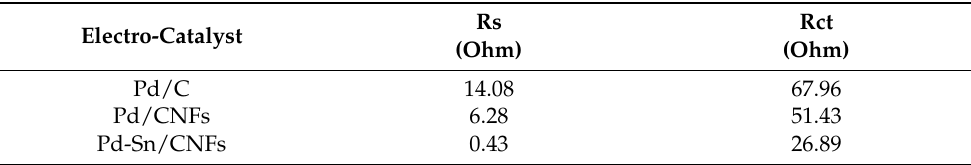
Table 6. EIS resistance values for electro-catalysts in methanol oxidation.